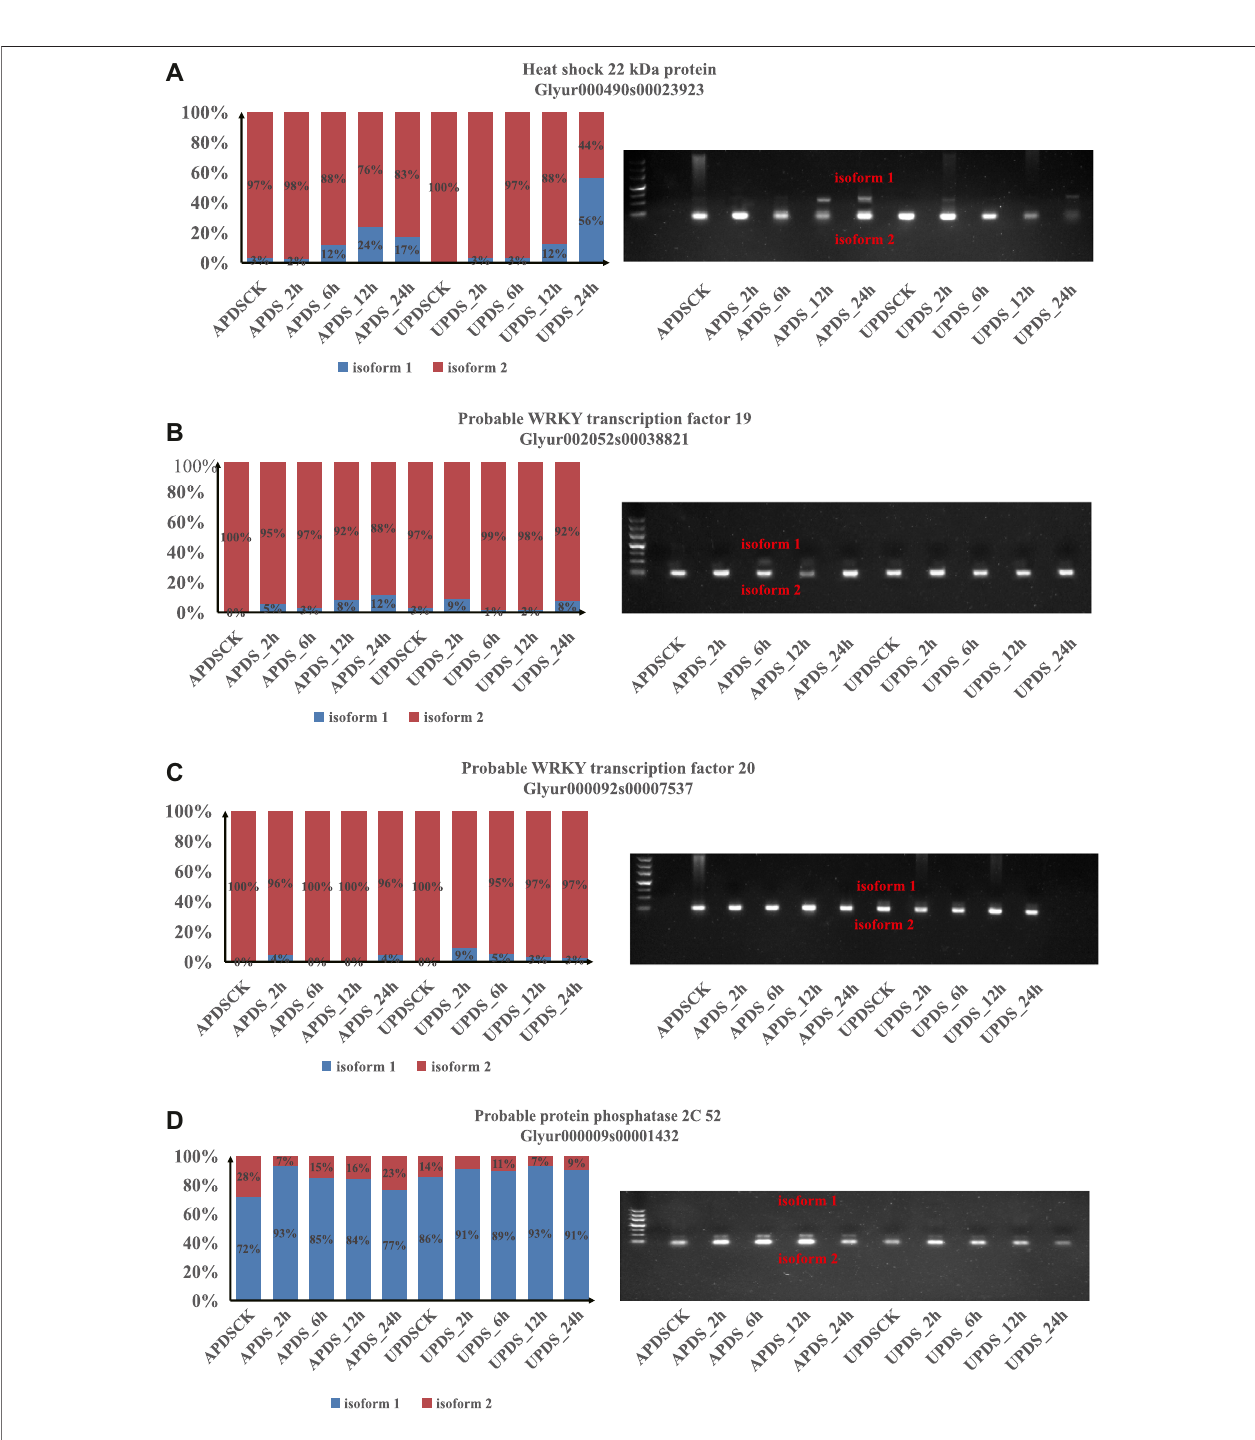
FIGURE7| ExperimentalvalidationofstressresponseeventsinlicoriceAPandUPbyRT-PCR. (A) Geneencoding22 kDaheatshockprotein; (B) Geneencoding probableWRKYtranscriptionfactor 19; (C) Geneencoding probabletranscriptionfactor 20; (D) Geneencoding probably protein phosphatase2C52. Inthe leftpanels, barsshowrelativeexpressionlevelsofalternativelysplicedisoforms1(blue)and2(red)inASat0,2,6,12,and24 hofdroughtstressasdeterminedfromRNA-seqdata. Panels on the right show results of RT-PCR analyses to detect splice variants using speci fi c primer pairs.